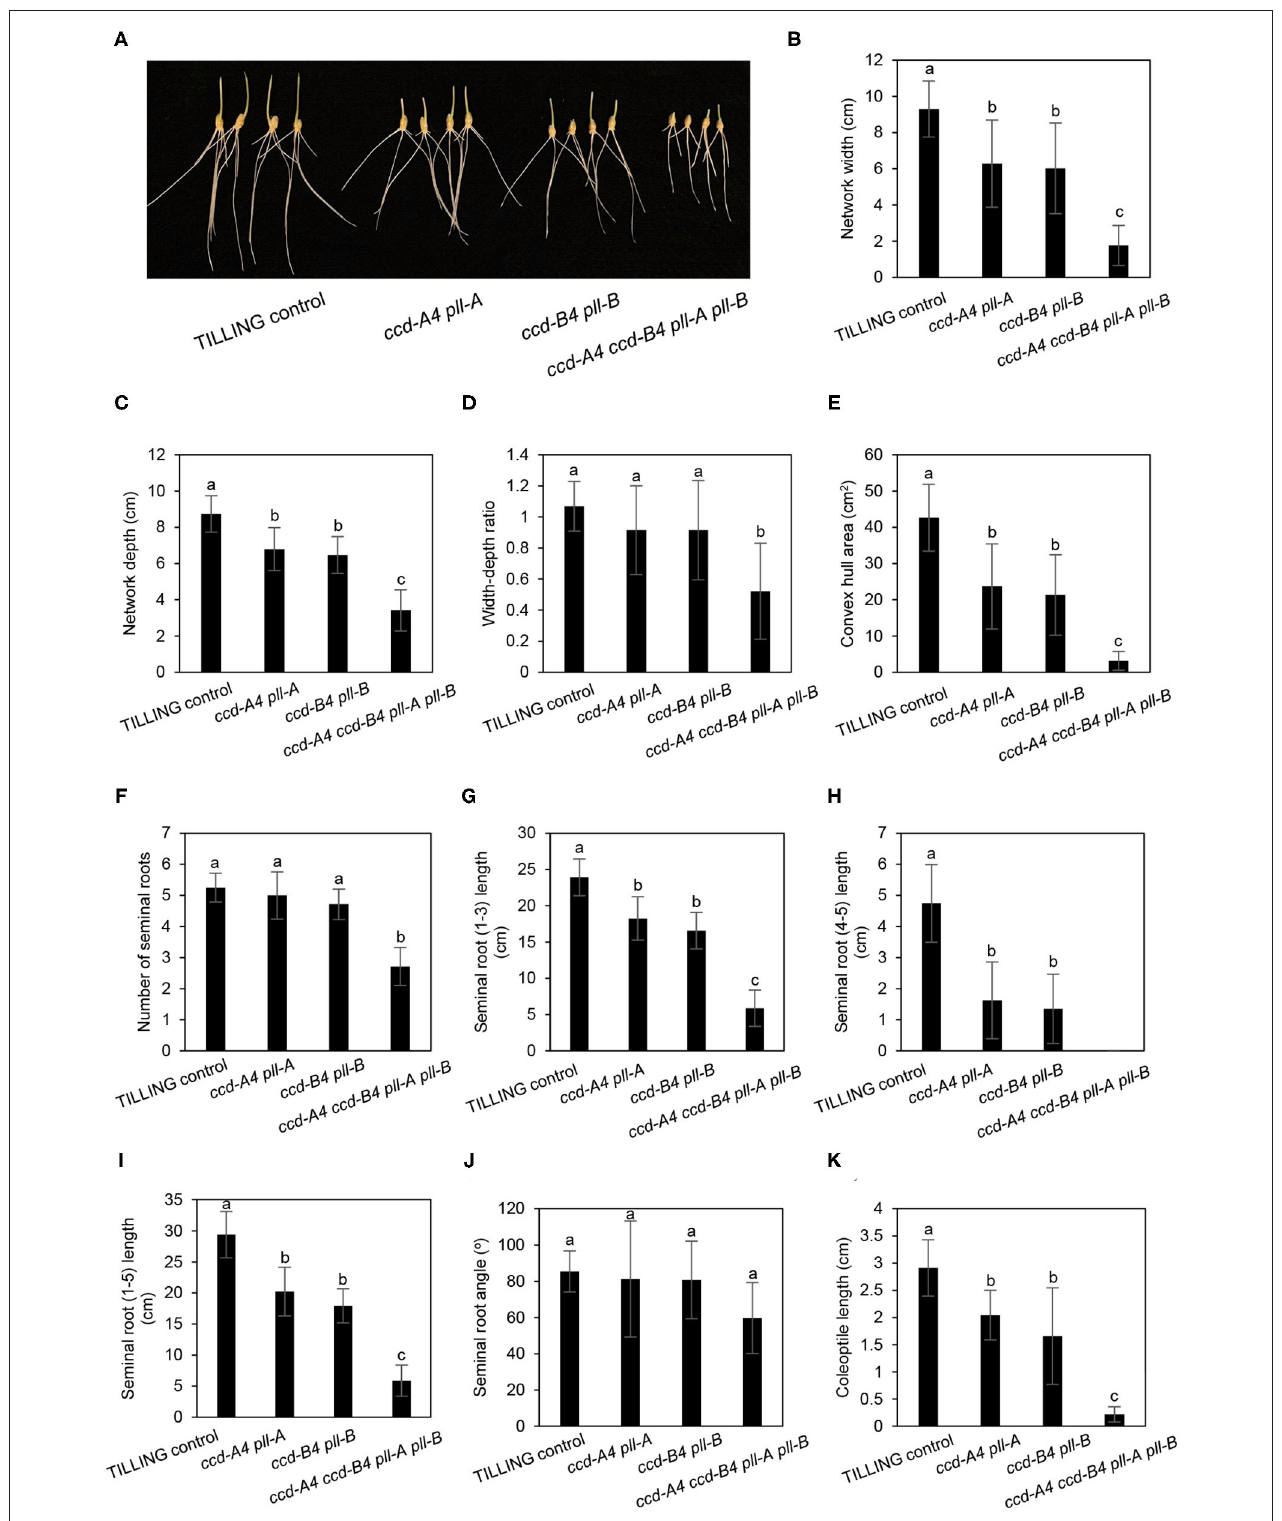
FIGURE 6 | Seminal root phenotyping of TILLING control and mutant seedlings grown under long-day conditions. (A) Image of 3-day-old seedlings grown under long-day conditions. (B–J) Represent different seminal root traits. (K) Coleoptile length. The mean ± standard deviation of 11 seedlings are shown. Different letters denote significantly different ( P < 0.05) for each seminal root trait or coleoptile length.